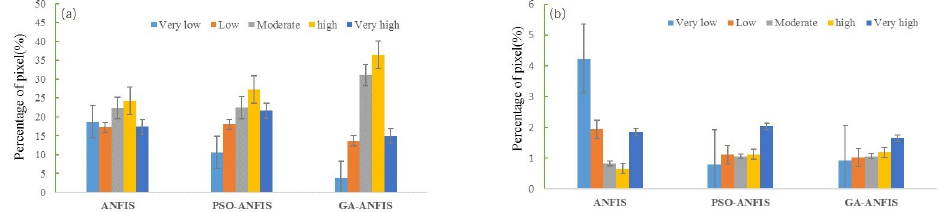
ity Figure 7. Distribution of probability levels ( a ) and fire density ( b ) in the different wildfire probabil ‐ ity maps.